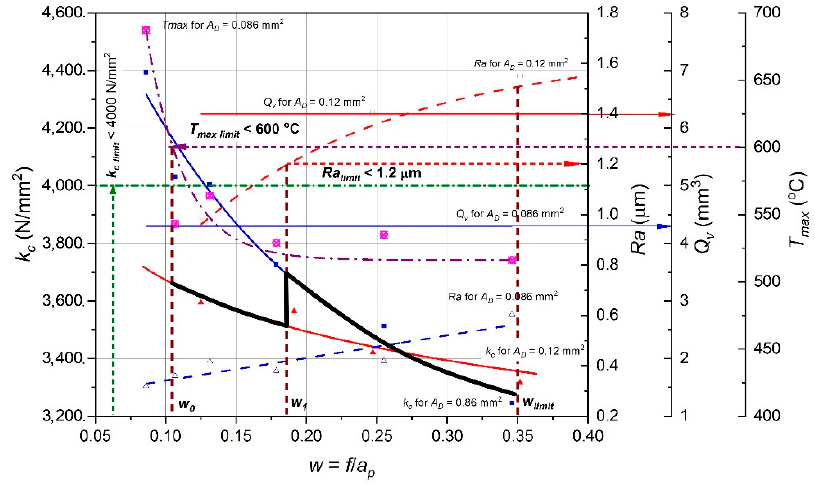
Figure 10. An example of the application of the algorithm for minimizing the value of specific cutting force when turning the Inconel 718 alloy using the DMLS method.